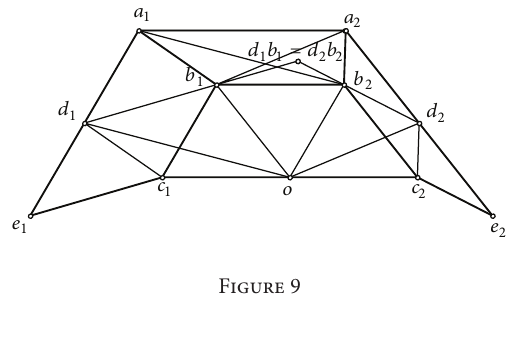
grams Par (𝑜, 𝑏 2 , 𝑎 1 , 𝑑 1 ) , Par (𝑜, 𝑏 1 , 𝑎 2 , 𝑑 2 ) follow from the